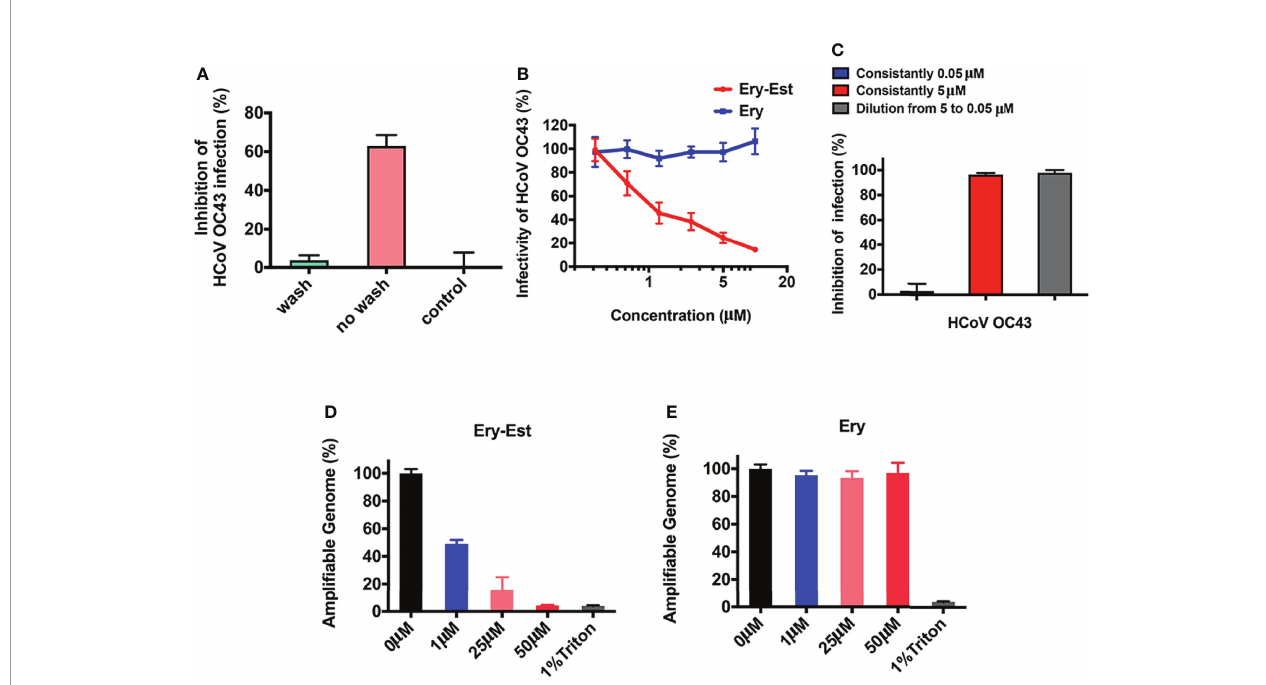
FIGURE 4 | Ery-Est irreversibly reduced the infectivity of HCoV-OC43. (A) Ery-Est inhibited HCoV-OC43 infection only by keeping Ery-Est present during the virus infection. (B) Ery-Est reduced the infectivity of HCoV-OC43 at a dose-dependent manner after Ery-Est was separated from viruses by PEG-8000 precipitation. (C) Ery-Est irreversibly inactivated the infectivity of HCoV-OC43. (D, E) Ery-Est treatment but not Ery treatment caused the release of HCoV-OC43 genomic RNA. Each experiment was performed in triplicate, and the data were presented as means ±